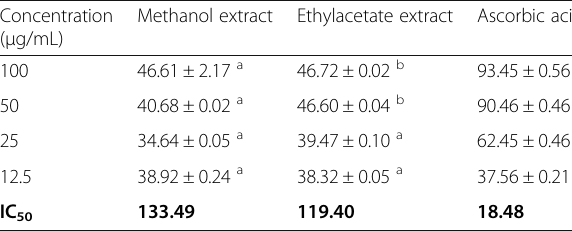
Table 2 1, 1-Diphenyl-2-Picryl Hydrazyl (DPPH) radical scavenging activities of Methanol and ethyl acetate extract of